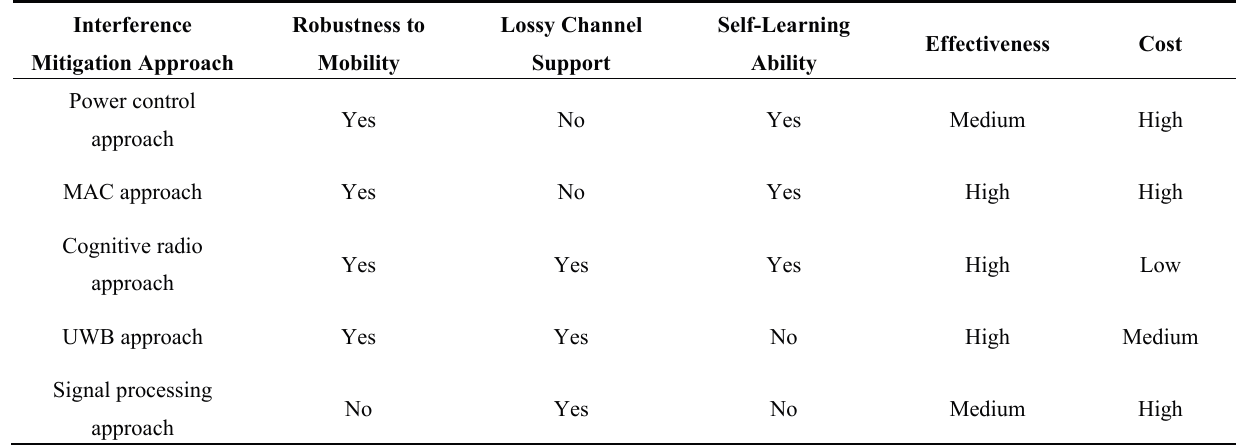
Table 4. Comparison of the five interference mitigation